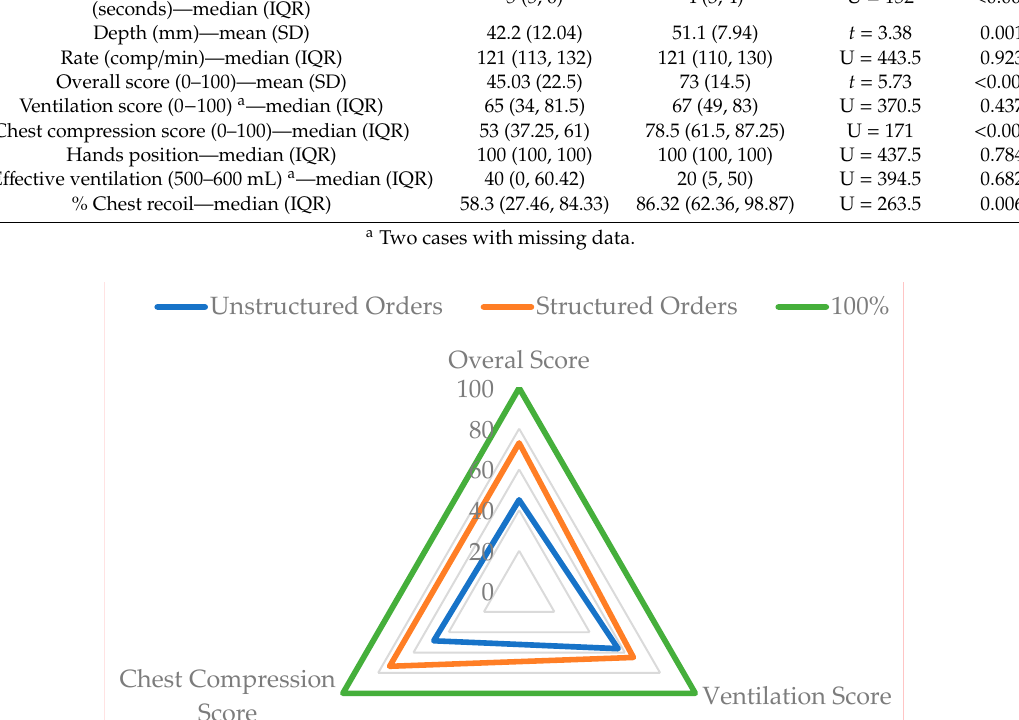
Figure 3. Comparison of the scores reached by each group, with respect to the maximum